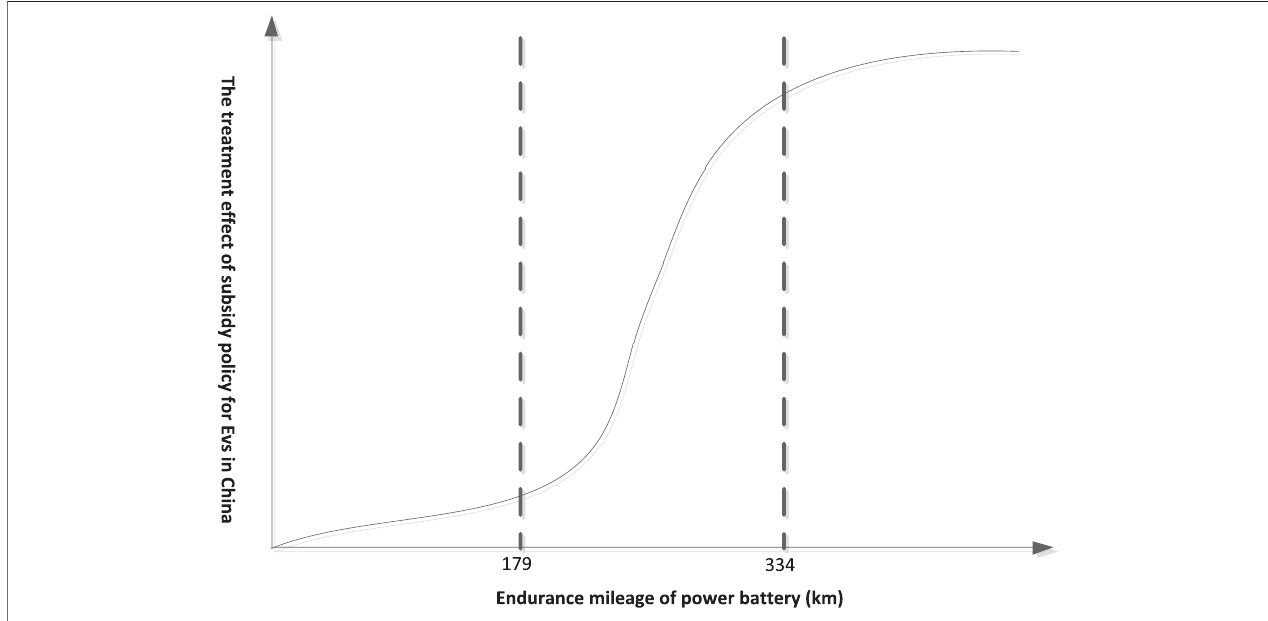
FIGURE 3 | Effect of EVs subsidy policies on consumers ’ willingness.